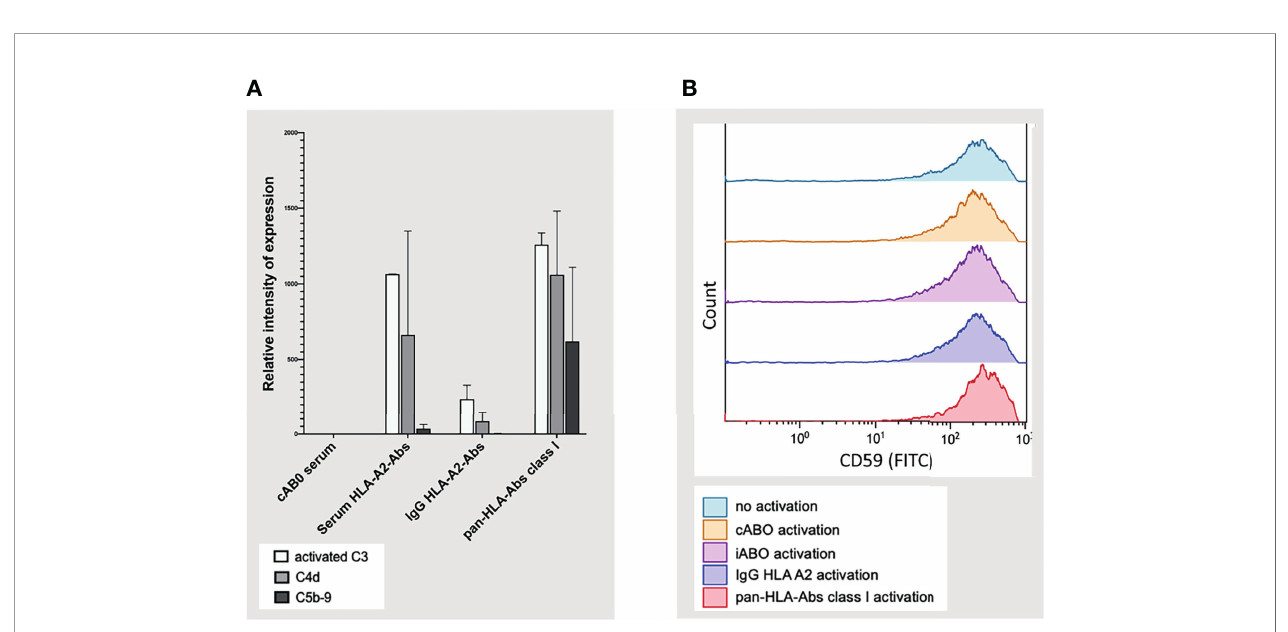
FIGURE 8 | Complement system activation on conditionally immortalized glomerular endothelial cells in vitro in fl ow cytometric analysis. Complement factors C3 (activated), C4d, and C5b-9 on conditionally immortalized glomerular endothelial cells in vitro in fl ow cytometric analysis are depicted in (A) with the four different incubation conditions plotted on the y-axis. Deposition of complement regulator, CD59, was measured in fl ow-cytometry under fi ve different incubation conditions (B) . cABO, ABO-compatible; HLA, Human Leucocyte Antigen; Abs, antibodies; IgG, Immunoglobulin G; FITC, Fluorescein isothiocyanate; iABO,